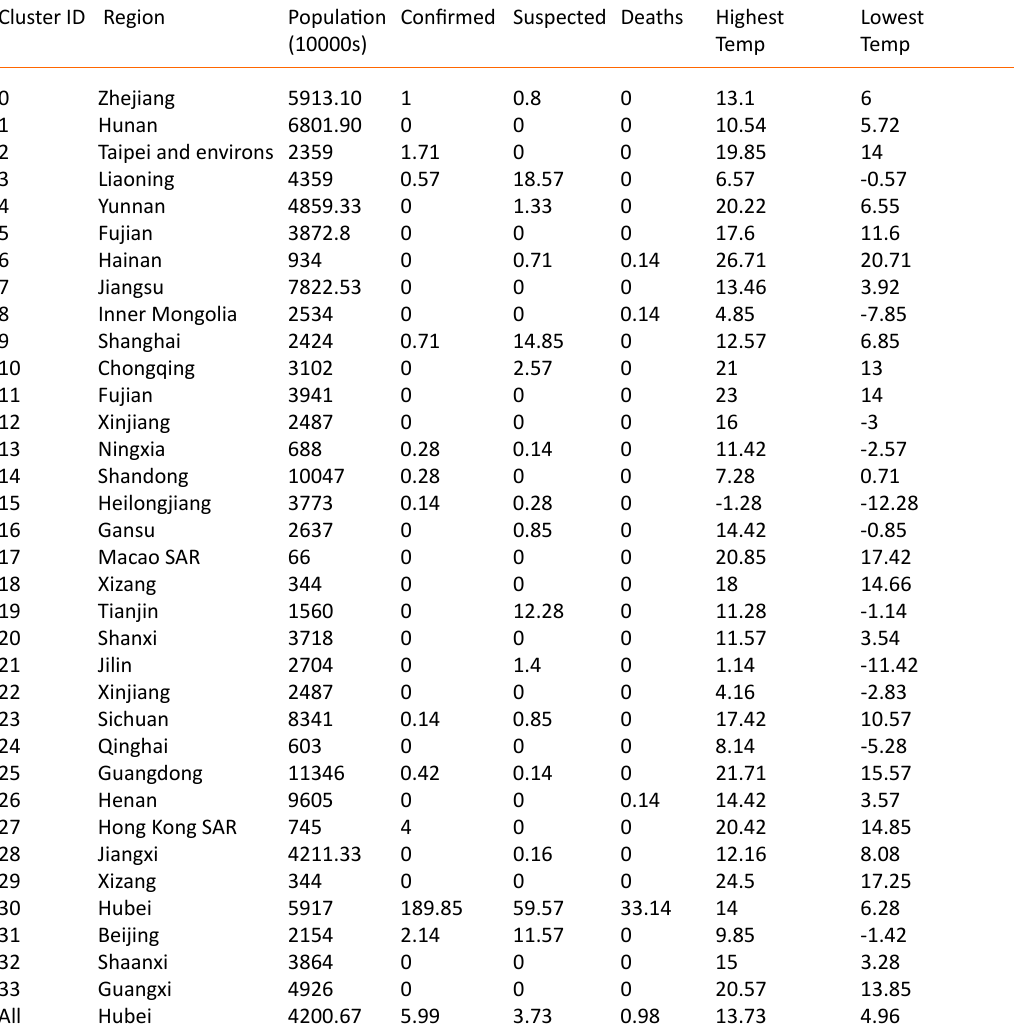
Table 3. K-means Cluster results on COVID-19 data set Cluster ID